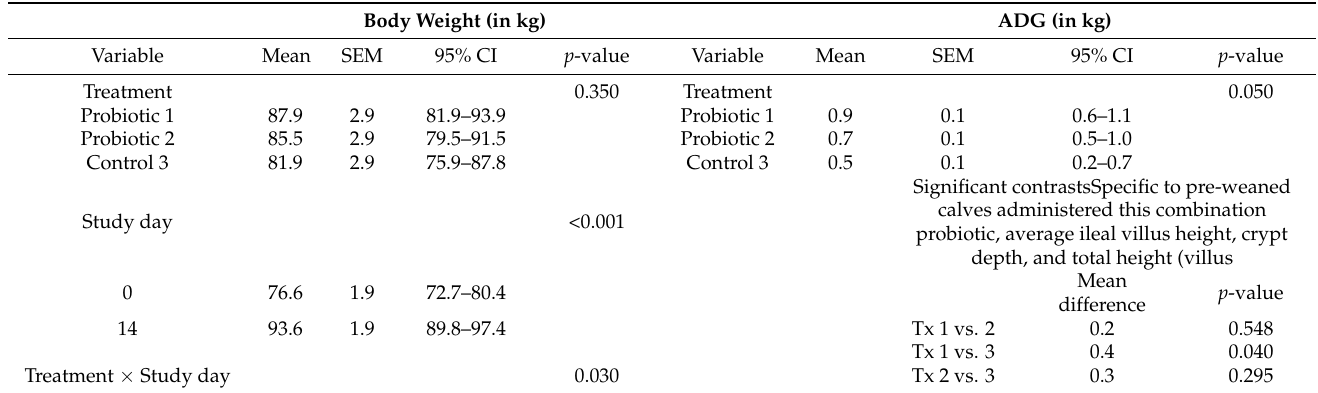
Table 2. Body weight and average daily gain (ADG) estimated from multivariable and univariable models in dairy calves supplemented with two probiotic products to reduce Clostridium perfringens . Body Weight (in